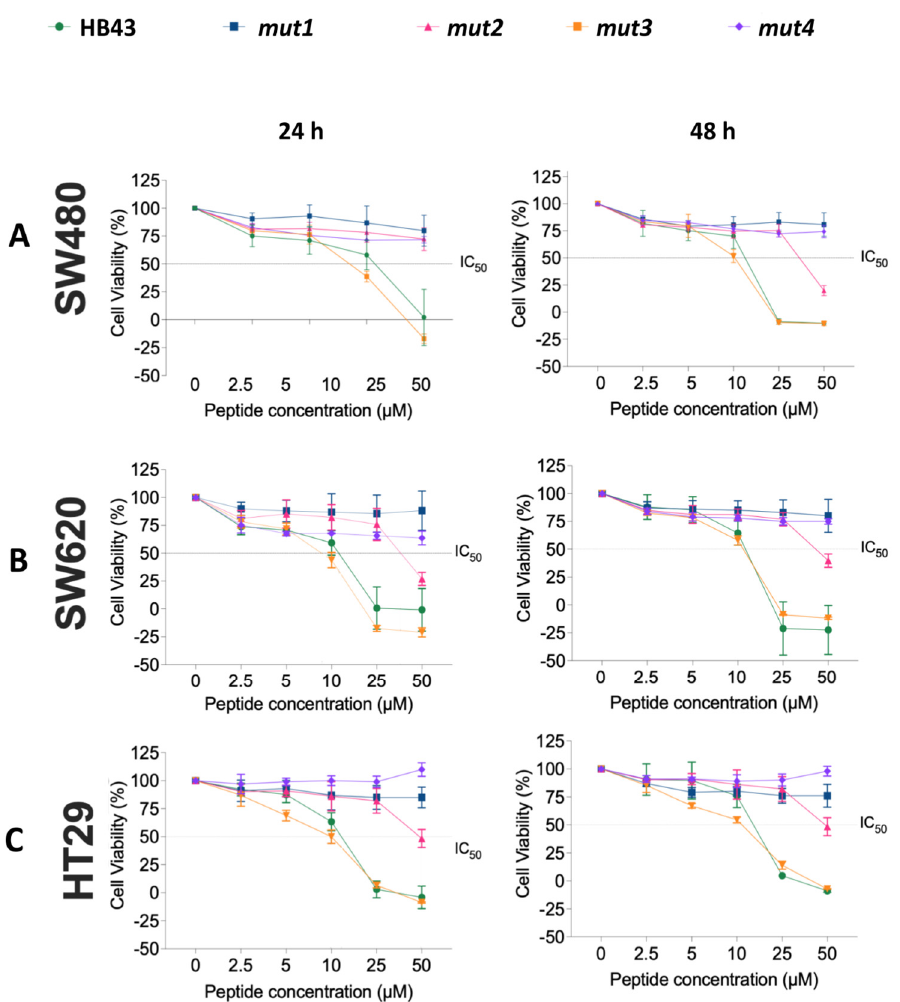
Figure 3. Effect of HB43 and mutants on cell viability of ( A ) SW480, ( B ) SW620, and ( C ) HT29 cells. Cells were treated with peptides for 24 h ( left ) and 48 h ( right ). Cell viability was measured using the AlamarBlue assay. Results were calculated as percent of control and represented as means ± S.D. of three independent experiments.